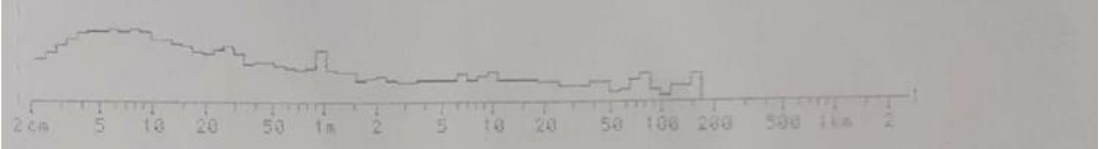
Figure 39. Mass spectrogram graphic obtained by the USTER Tester 3.